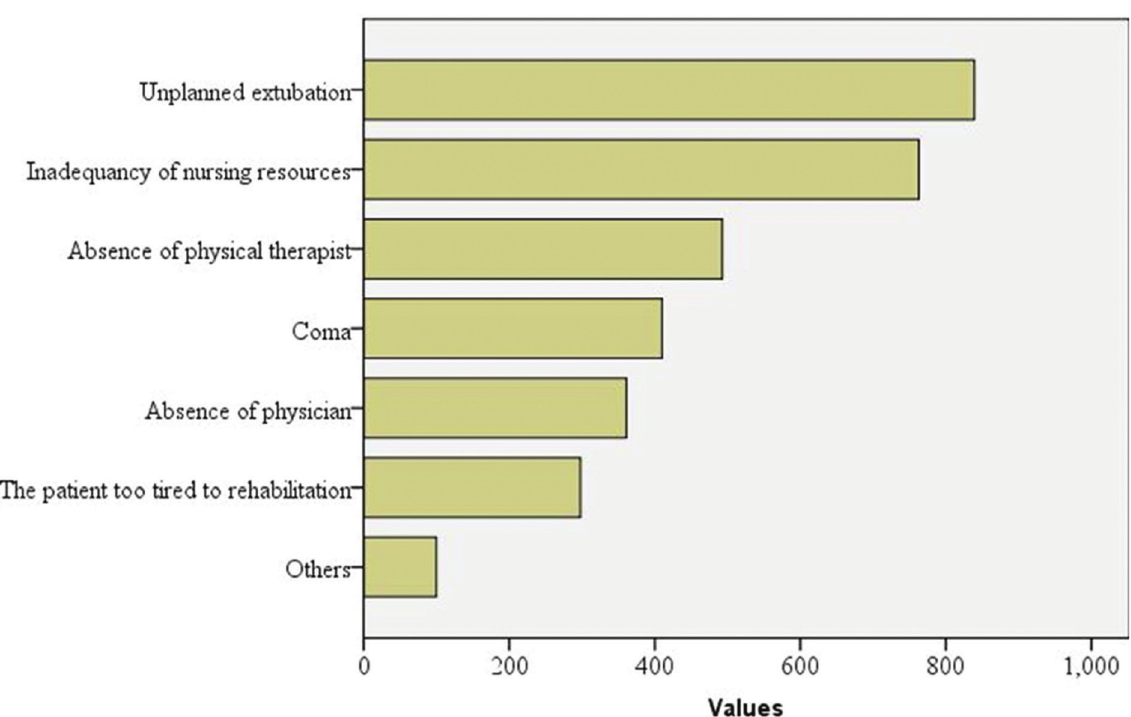
Figure 3. Nursing reported barriers to early mobility ( n =1,353).